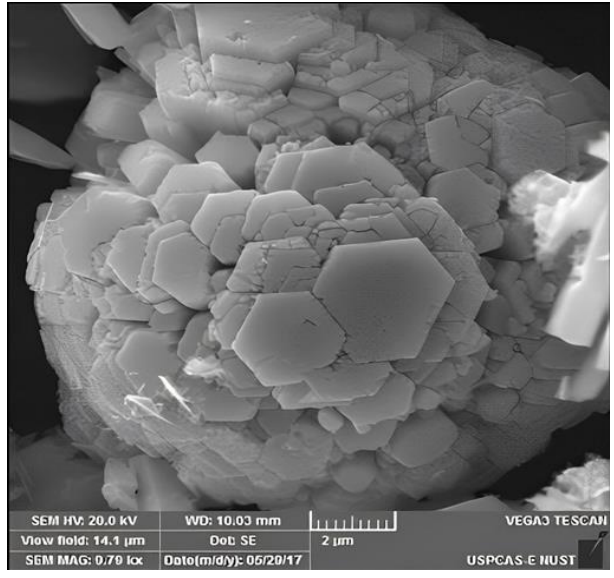
Figure 11. SEM micrograph of cauliflower-like ZnO nanostructures synthesized by CBD method (magnification-2 µm).